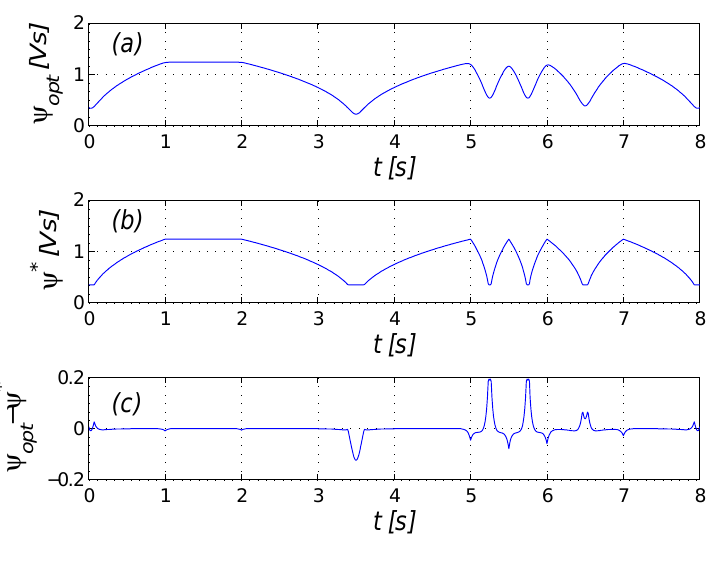
Figure 3. ( a ) Optimal flux magnitude; ( b ) flux reference resulting from (40); ( c ) deviation from optimal